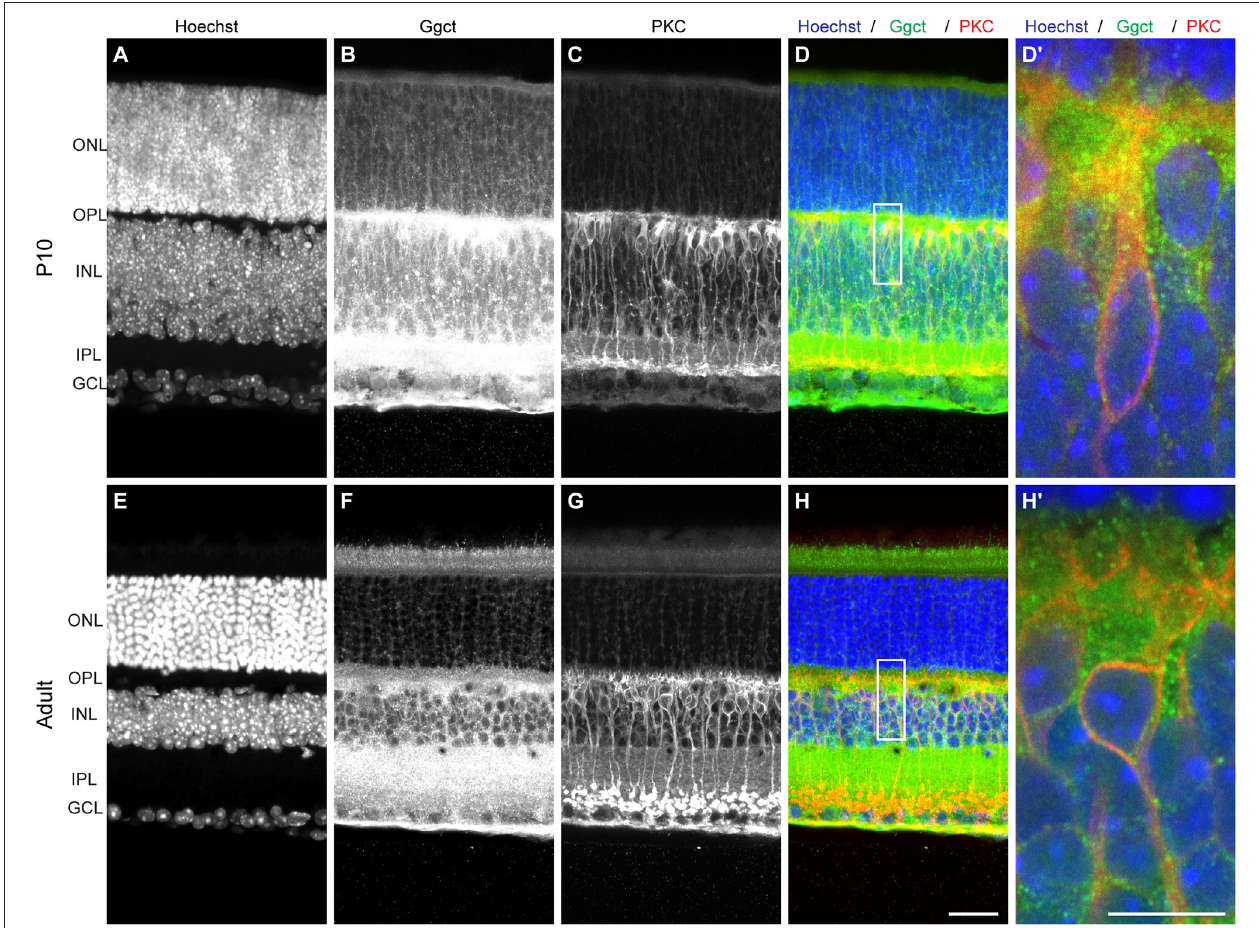
FIGURE 3 | (A–D) Ggct immunofluorescence is most conspicuously detected in P10 retinas in the outer portion of the INL and IPL, and is occasionally but not exclusively localized to PKC-positive RBCs. (E–H) The same pattern is seen in adult retinas. (D ′ , H ′ ) Show enlarged regions in (D,H) . Scale bar: (A–H) = 25 µ m; (D ′ , H ′ ) = 10 µ